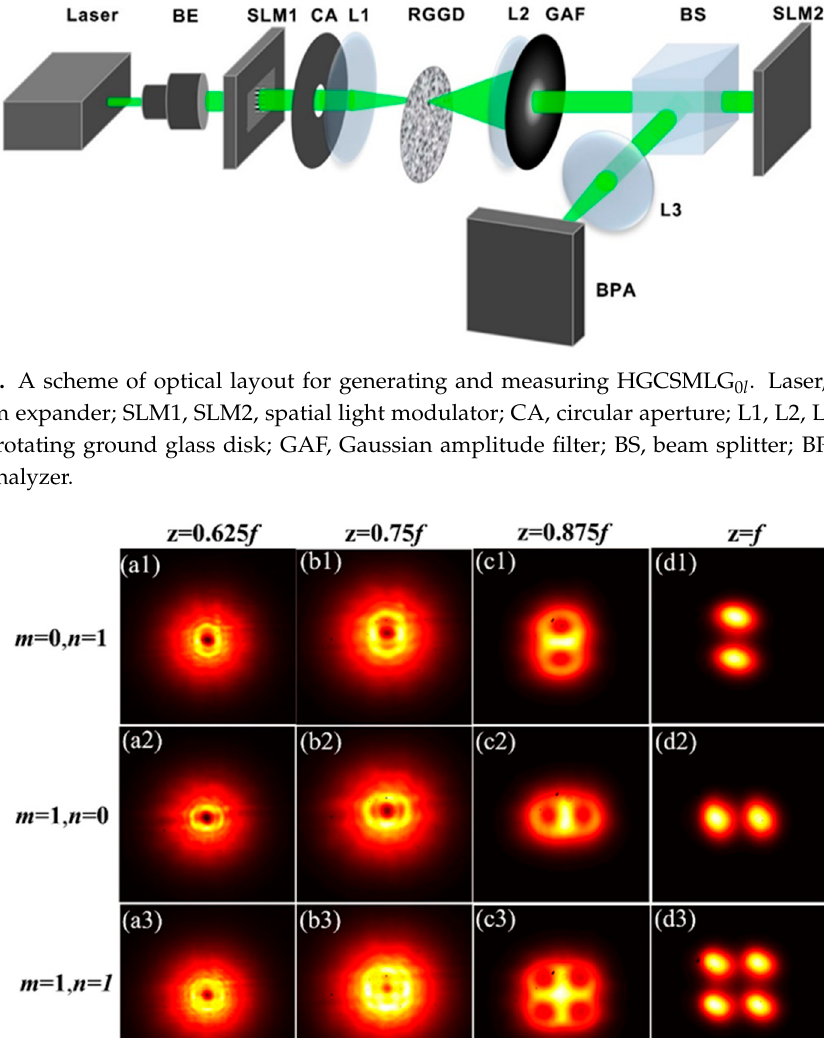
Figure 9. A scheme of optical layout for generating and measuring HGCSMLG 0 l . Laser, 532 nm; BE, beam expander; SLM1, SLM2, spatial light modulator; CA, circular aperture; L1, L2, L3, lenses; RGGD, rotating ground glass disk; GAF, Gaussian amplitude filter; BS, beam splitter; BPA, beam profile analyzer.